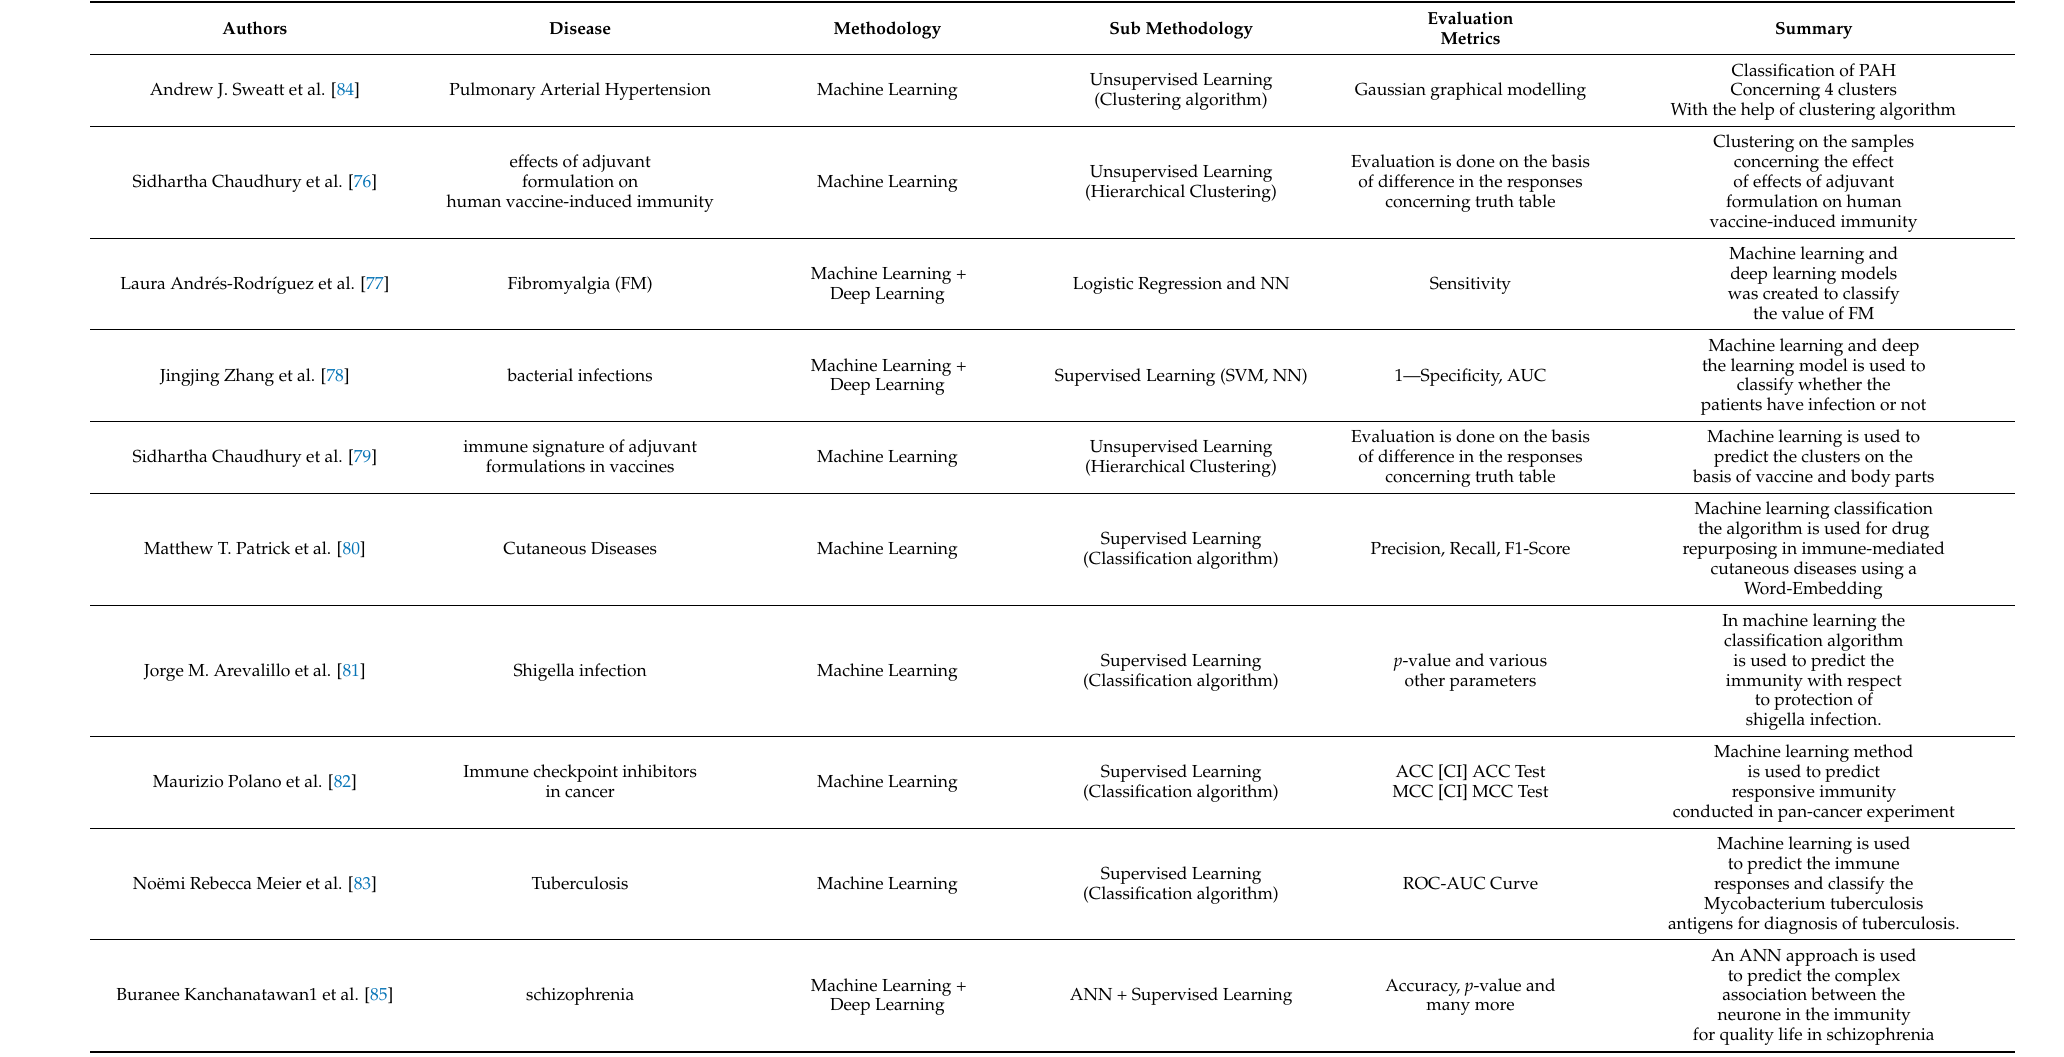
Table 5. A Review of Applications of Machine Learning in